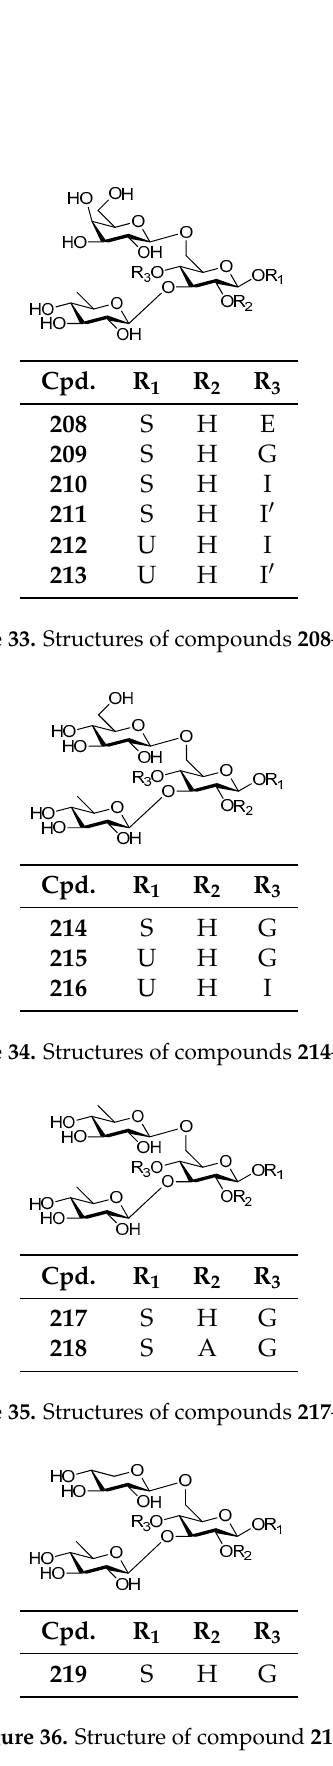
Figure 37. Structure of compound 220 .